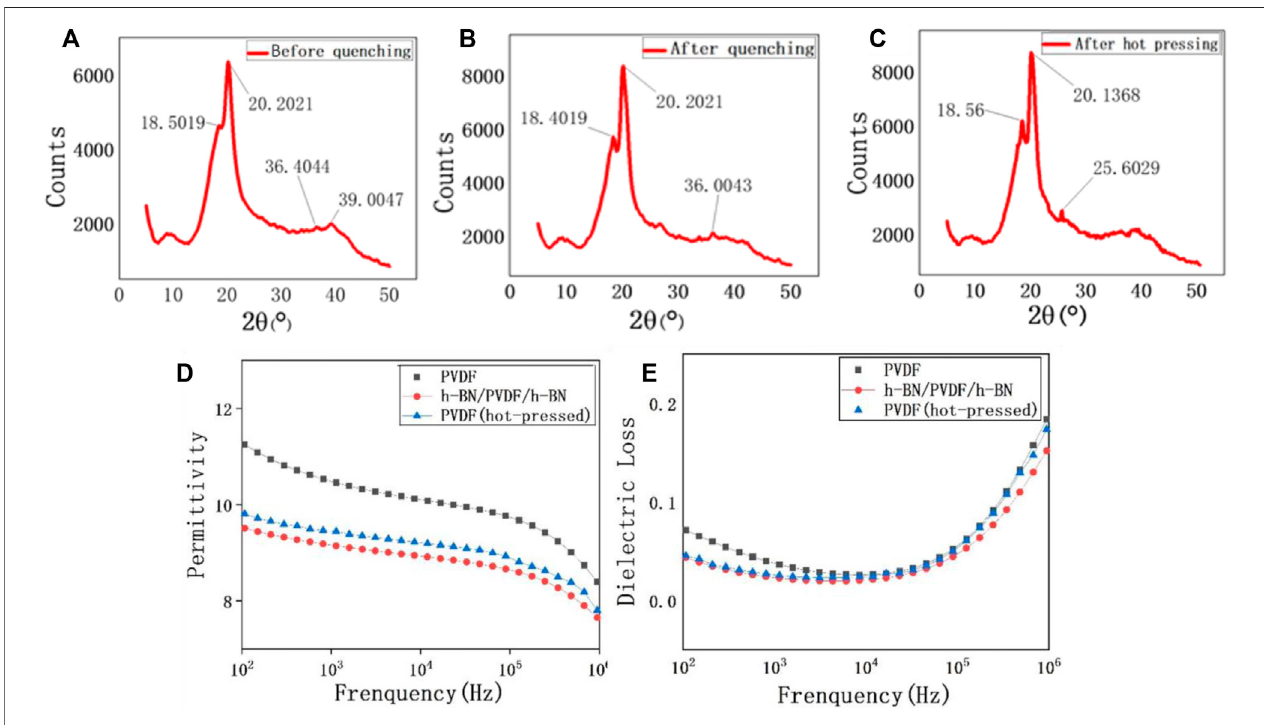
FIGURE 3 | XRD patterns of the PVDF fi lm before quenching (A) , after quenching (B) , and after hot pressing (C) . Frequency-dependent permittivity of pristine PVDF, h-BN/PVDF/h-BN, and hot-pressed PVDF fi lms (D) . Frequency-dependent dielectric loss of pristine PVDF, h-BN/PVDF/h-BN, and hot-pressed PVDF fi lms (E) .